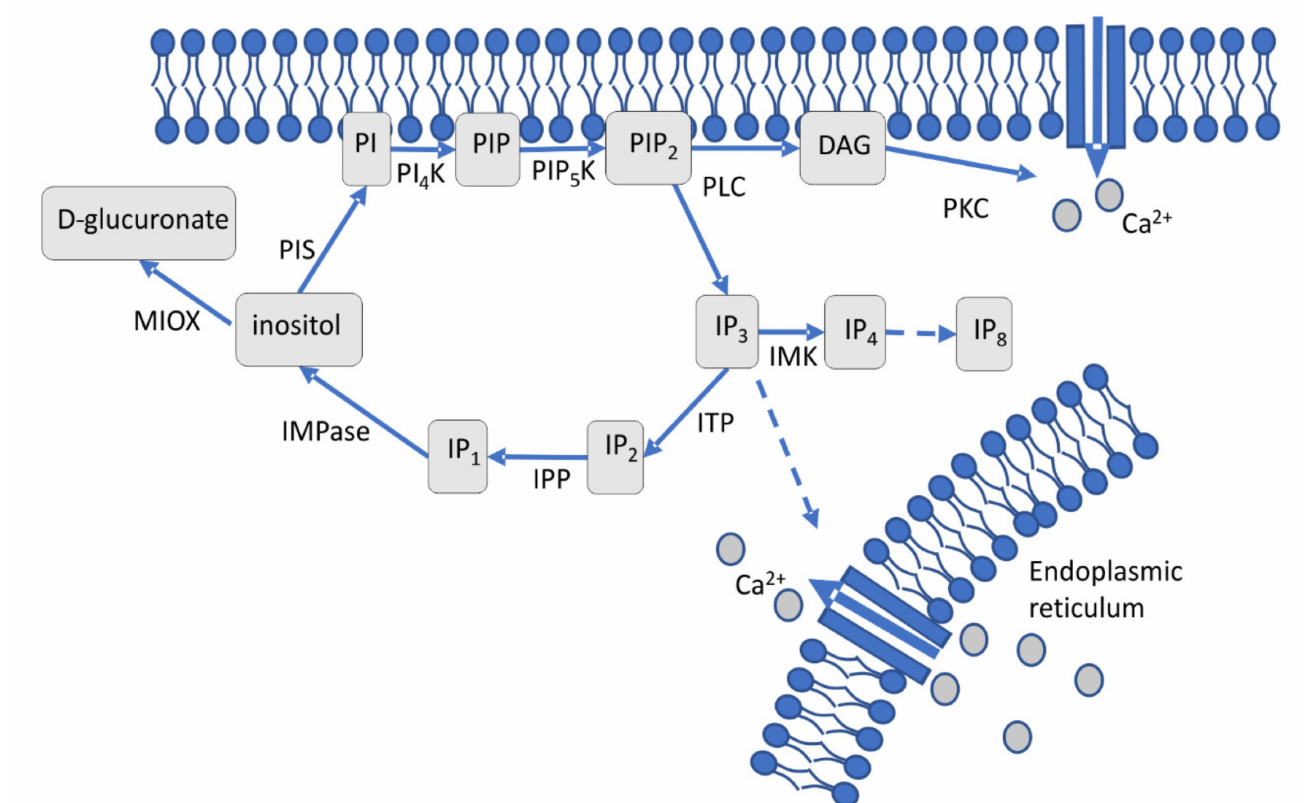
Figure 1. Schematic representation of cellular inositol signaling. Phosphatidylinositol specific phospholipase C (PLC) cleaves phosphatidylinositol (PI)-4,5-bisphosphate (PIP 2 ) generating two second messengers, diacylglycerol (DAG) and inositol 1,4,5 triphosphate (IP 3 ). IP 3 can be diverted into higher phosphorylated IP 4 through IP 8 or dephosphorylated to inositol through IP 2 and IP 1 . Inositol, regenerated by IMPase from IP 1 , is the precursor of membrane-bound PIP 2